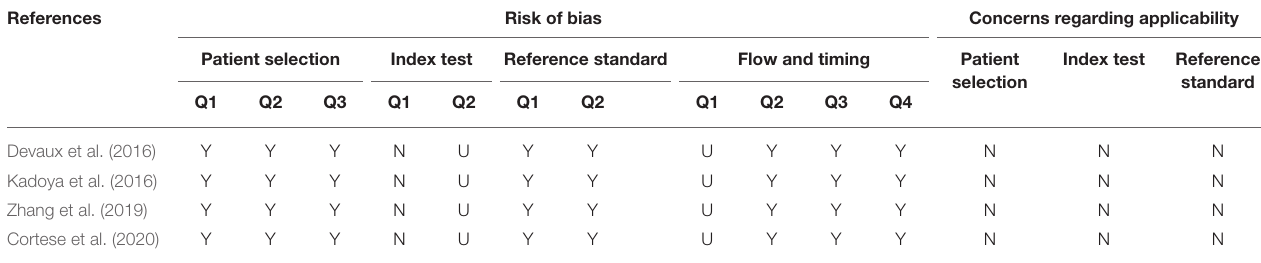
TABLE 6 | QUADAS-2 criteria for included studies.